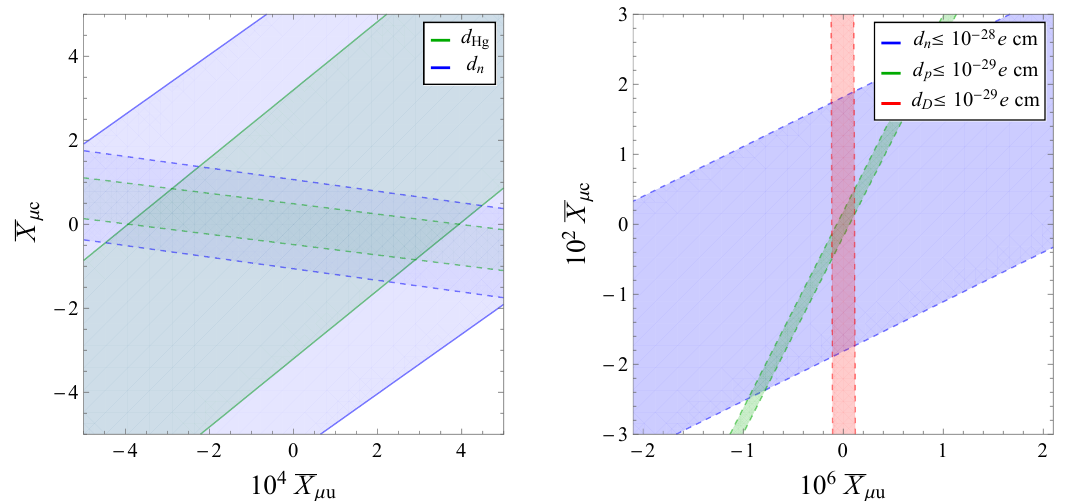
Figure 7 . Left panel: current constraints from various EDM experiments assuming only the (cid:22) X (cid:22) X (cid:22)u and (cid:22)c couplings are present. Solid (dashed) lines indicate the constraints for g ( g c = m s g s ). Right panel: constraints using the expected sensitivities of prospected neutron, T T m c proton, and deuteron EDM experiments using g c